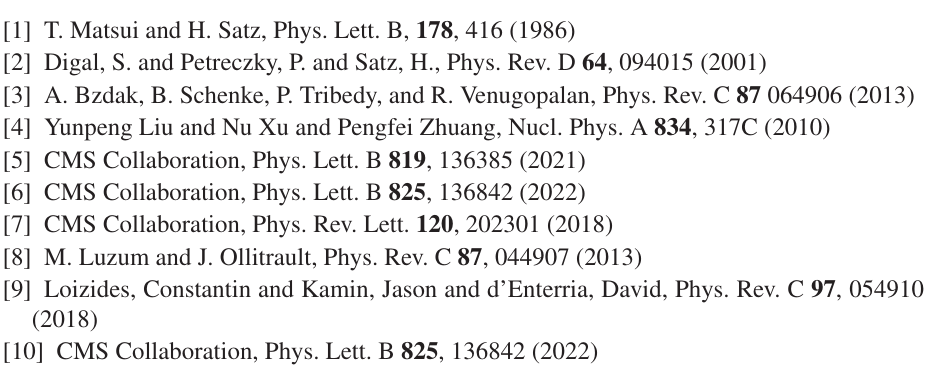
Figure 2. The v 2 (upper) and v 3 (lower) values as functions of p T (left) and J /ψ (blue circles) and prompt ψ (2S) (green squares). The results for p T < 6.5 and p T > 6.5 GeV / c are diplayed in the rapidity range of 1.6 < bins for the right panel is 6.5–50 GeV / c and rapidity of uncertainties, and the rectangular bands show the systematic